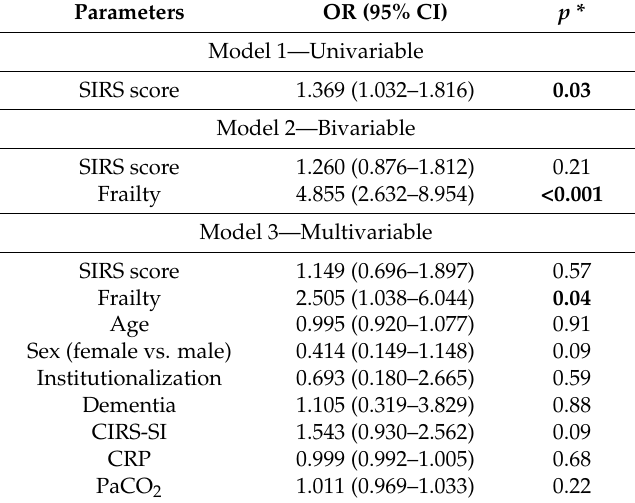
Table 5. Logistic regression analysis showing the association of SIRS score at admission with the secondary study outcome (pooled mortality three months after discharge) in elderly patients with suspected sepsis who completed the study follow-up ( n =